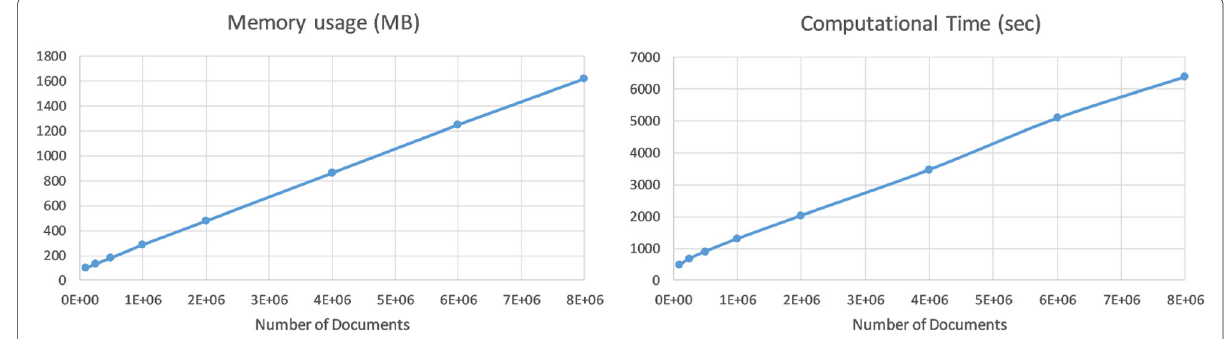
Fig. 4 Memory usage and computational time of the FBHC algorithm using subsets of the PubMed dataset running on a local